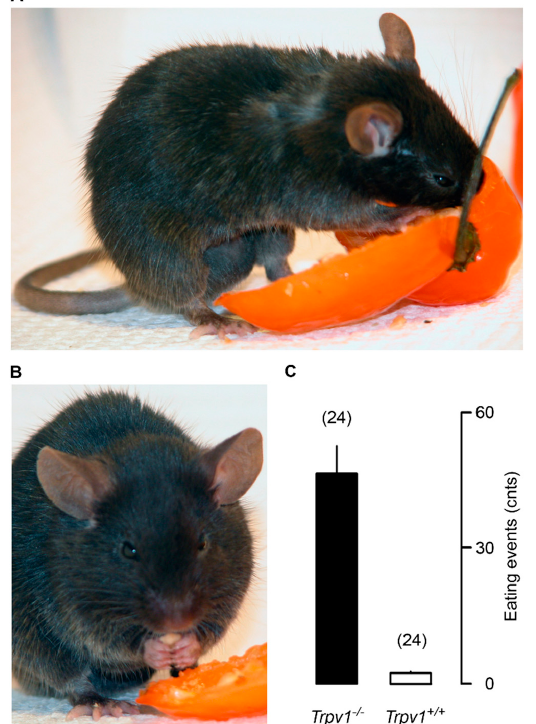
Figure 3. Trpv1 knockout mice are insensitive to capsaicin and eagerly consume habanero chili pepper (panel A ), including the hottest parts such as the septa and the seeds (panel B ). Panel ( C ) shows the mean number of pepper-eating events during a 20-min period. Reproduced with permission from [132]. However, a second study [132] came to a very different conclusion. Young TRPV1- null mice stayed lean and physically active (Figure 3A) but becoming old these animals became obese (Figure 3B) and “lazy”, with enhanced hepatic steatosis [132,133]. The aging TRPV1-null mice even gained more weight on normal chow (Figure 4). Adding to the confusion, a third study found no difference in weight gain between TRPV1-null and wild-type mice [134].